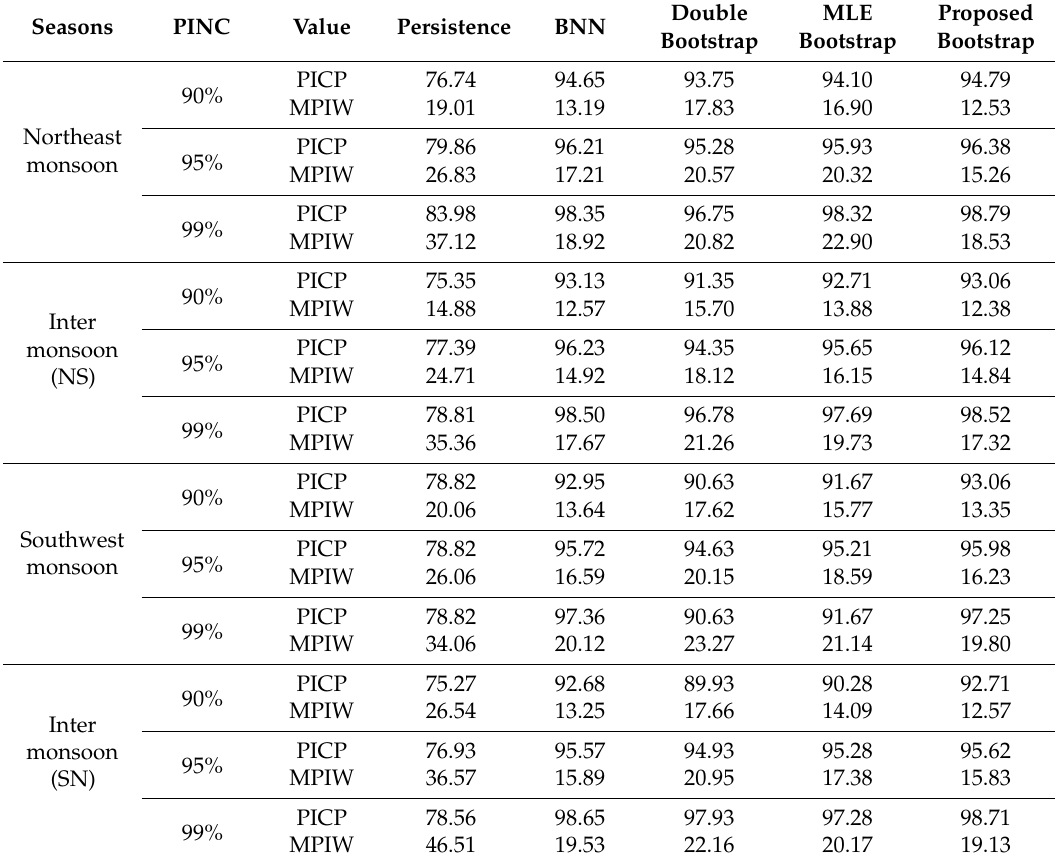
Table 1. Performance comparison of various constructed PIs in different